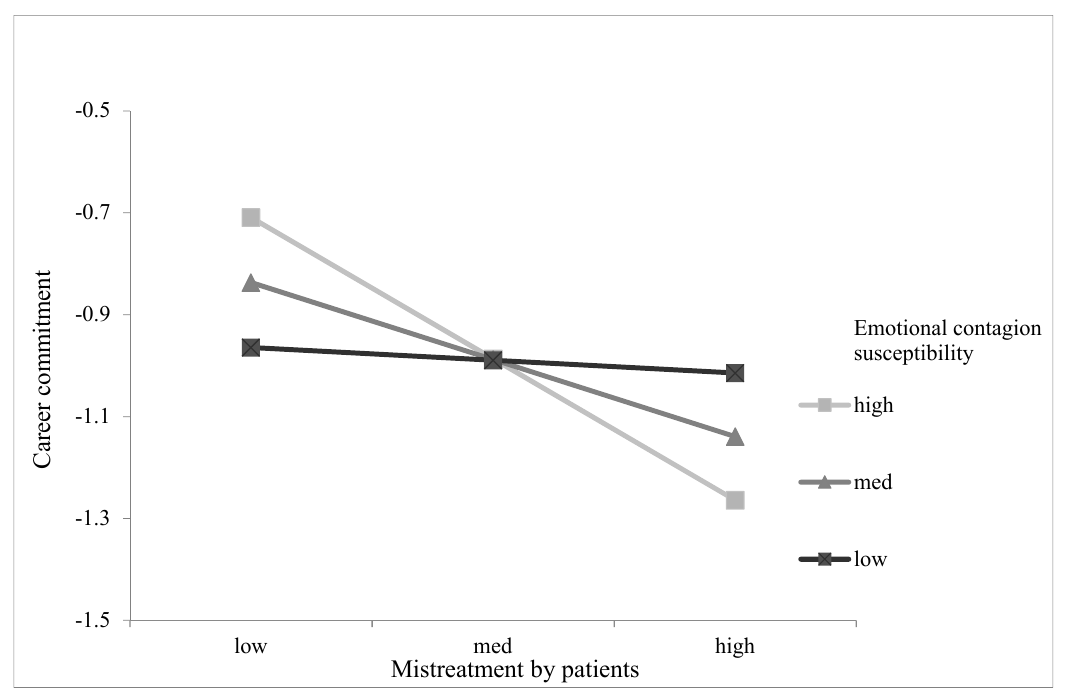
Figure 2. Interaction between mistreatment by patients and emotional contagion susceptibility on career commitment. Table 3. Results of simple slope